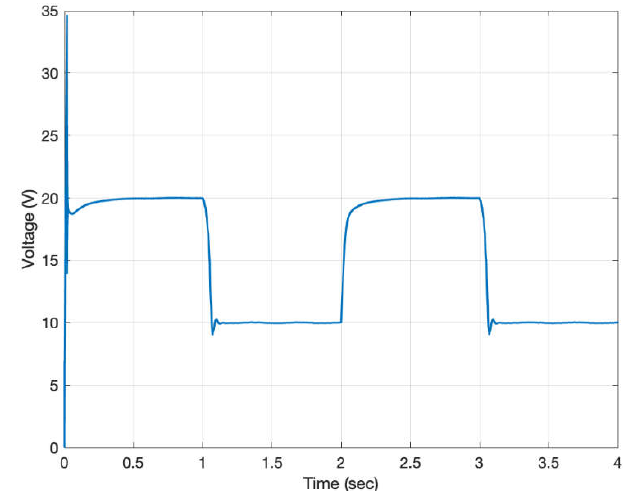
Figure 16. Fuzzy controller for voltage regulation simulation.